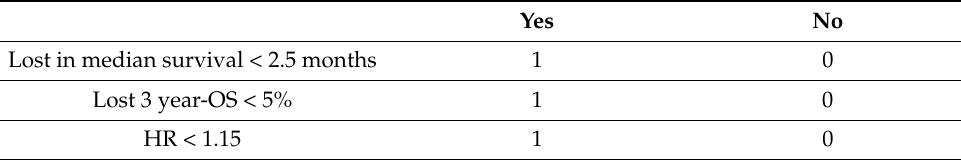
Table 5. ESMO-M non inferiority (NI)designed studies